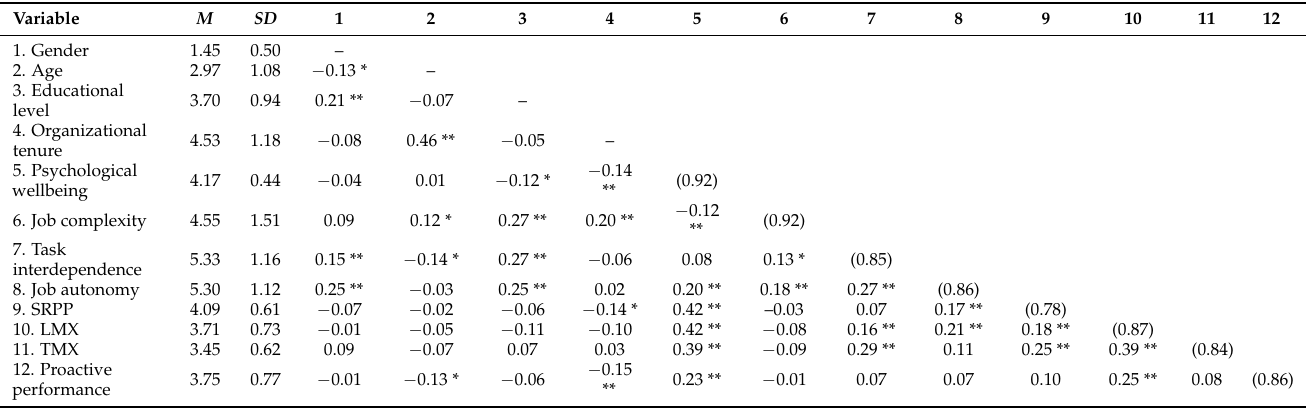
Table 2. Descriptive Statistics and